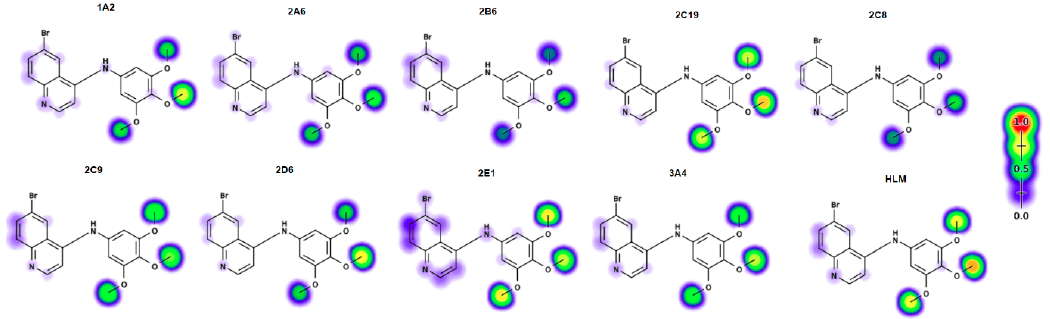
Figure 8. Compound 1 in XenoSite’s P450 Metabolism P450 1.0 algorithm.